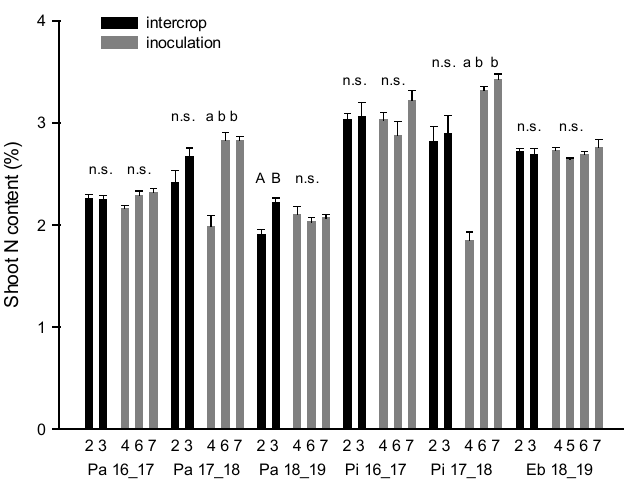
Figure 3. Shoot N content soybean intercrop. For explanations, see Figure 1.